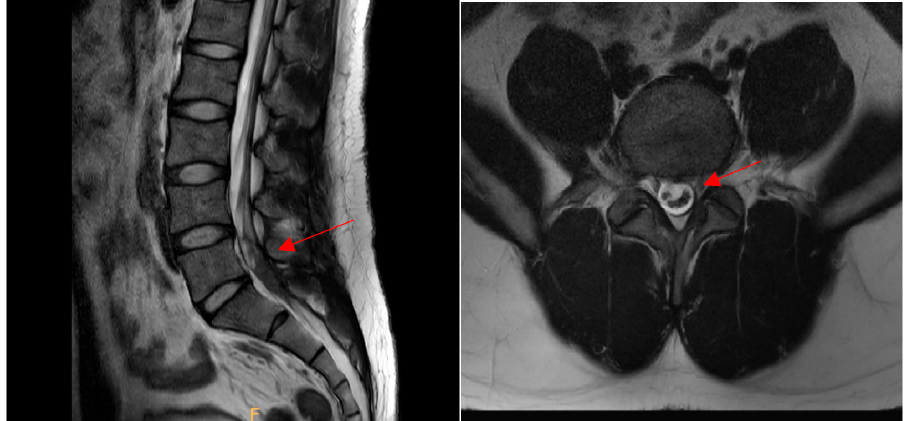
Figure 4. Magnetic resonance imaging (T2) showed a slight decrease in the size of the hematoma on the left side (arrow). The intradural hematoma on the right side was also decreased in size (arrow). Six months after symptom onset, the pain Numeric Rating Scale (NRS) score was 0, and no other neurological findings were observed (Figure 5, flow diagram).